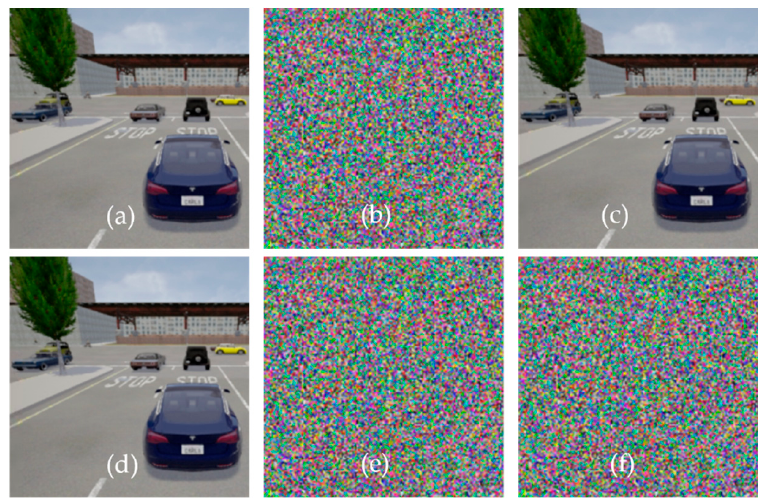
Figure 8. Logistic map-based encryption system. ( a – c ) represent the original, encrypted, and decrypted image frames with the same key, respectively, while ( d ) represents the original, ( e ) the encrypted, and ( f ) the decrypted image using the incorrect key.